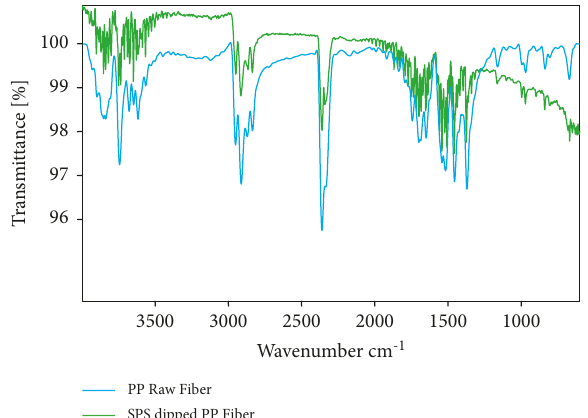
Figure 3: FTIR analysis of raw and SPS-dipped PP fibers.